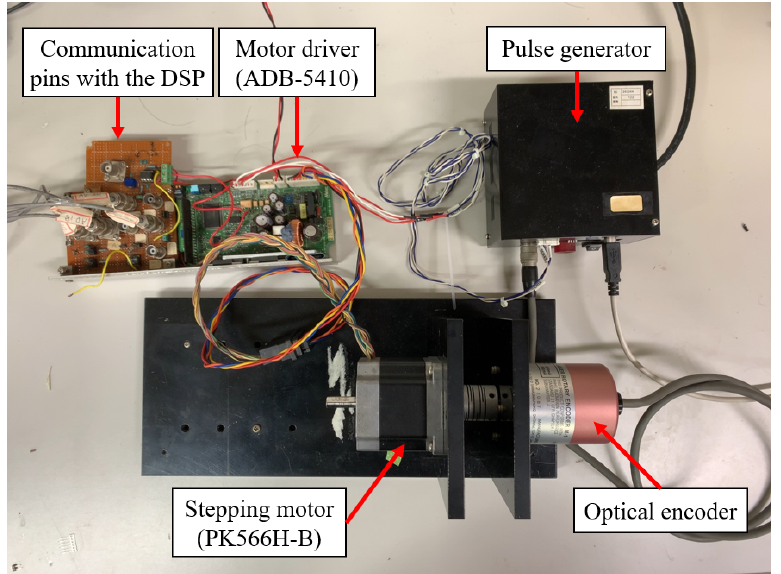
Figure 9. Experimental